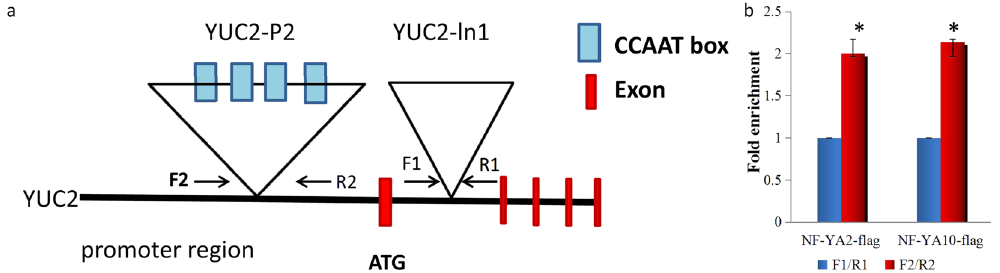
Figure 7. Chromatin immunoprecipitation (ChIP) assay in NF-YA2-FLAG and NF-YA10-FLAG plants. ( a ) Schematic structure of genomic sequences of yuc2 and the regions examined by ChIP. Two pairs of primers were used. Primer YUC2-P2 covered the promoter region containing the CCAAT cis -element. ( b ) Relative levels of qPCR products from the ChIP assay. Data were from one experiment with three technical replicates. Values are means ± SD, n =